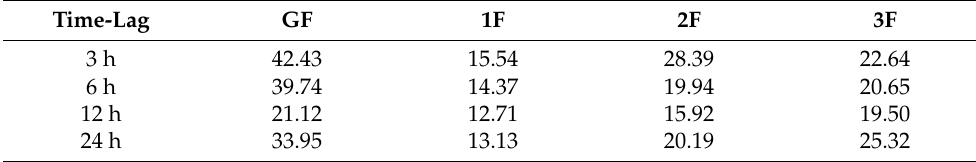
Table 2. Error comparison of the time-lag change using CV(RMSE) [%]. Time-Lag